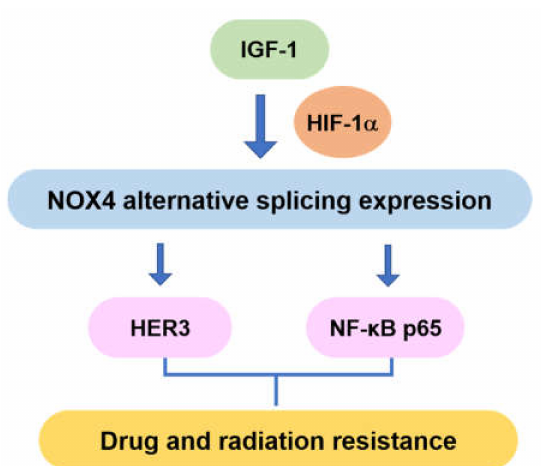
Figure 7. Overall model of NOX4 signaling in ovarian